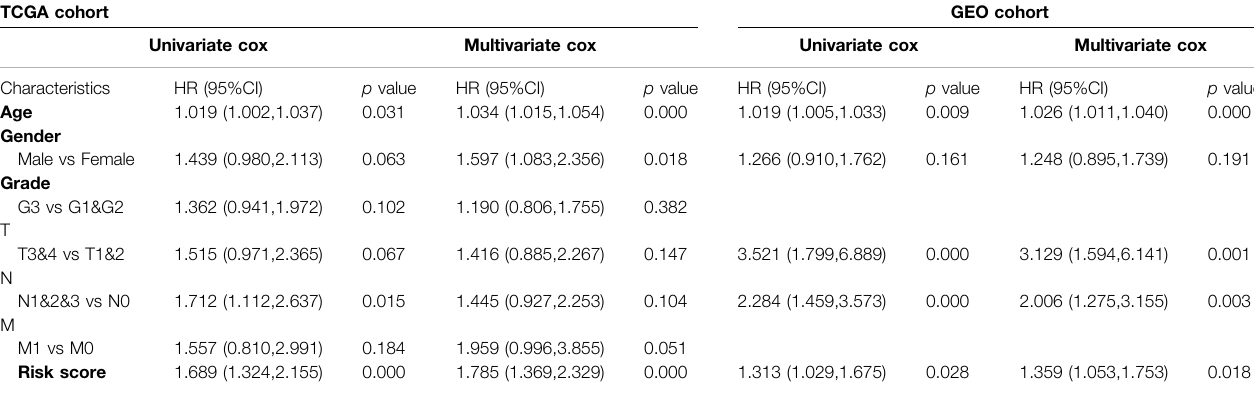
TABLE 2 | Cox regression analysis of risk score in TCGA and GEO